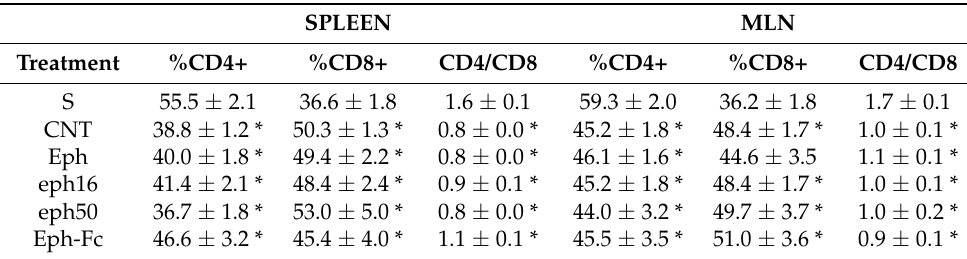
Table 2. Effects of EphA/ephrin-A ligands on TNBS-induced changes of spleen and MLN T cells count.